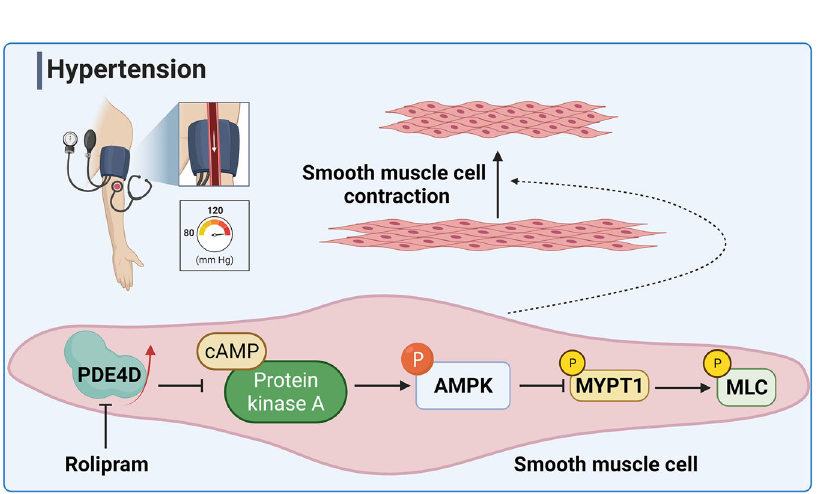
Fig. 8 PDE4D promotes Ang II-induced hypertension in mice. PDE4D exacerbates Ang II-induced vasocontraction by affecting SMC contraction, consequently contributing to hypertension. The mechanism by which PDE4D aggravates SMC contraction likely involves the PKA-AMPK-MYPT1-MLC signaling pathway. PDE4 inhibitor, rolipram, showed a therapeutic effect on Ang II-induced hypertension in mice primarily through PDE4D in SMCs. The image was created with BioRender.com, and acquired the permission for use and proper